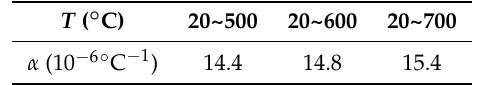
10 of 15 Figure 8. Stress-strain curves of GH4169 at different temperatures.